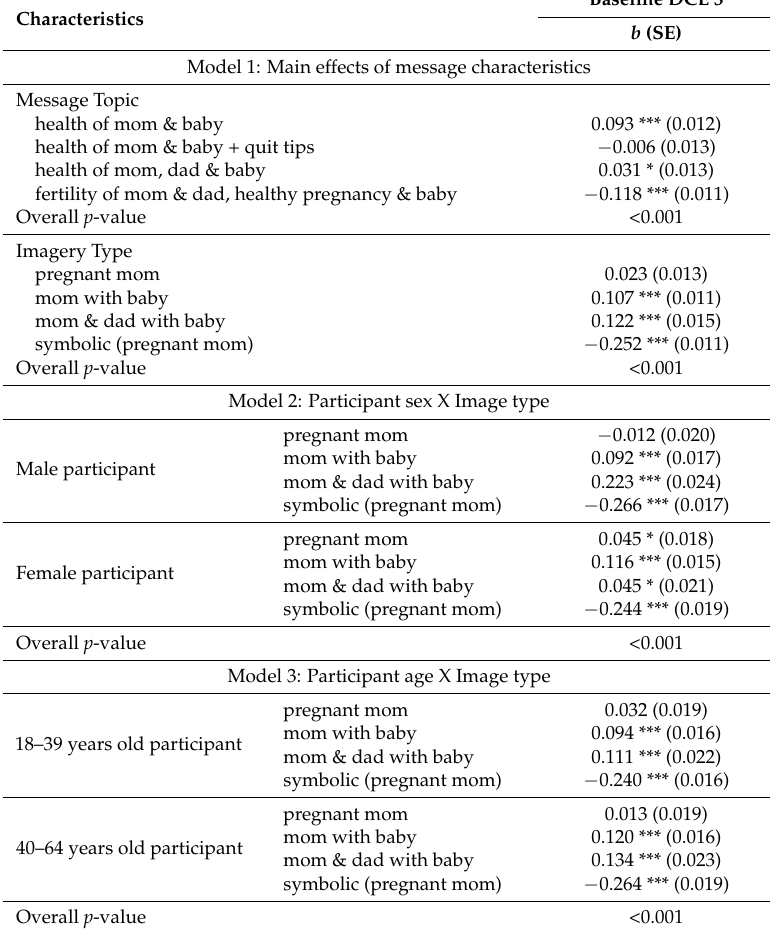
Table 4. Effects of reproductive health benefit message characteristics on quit